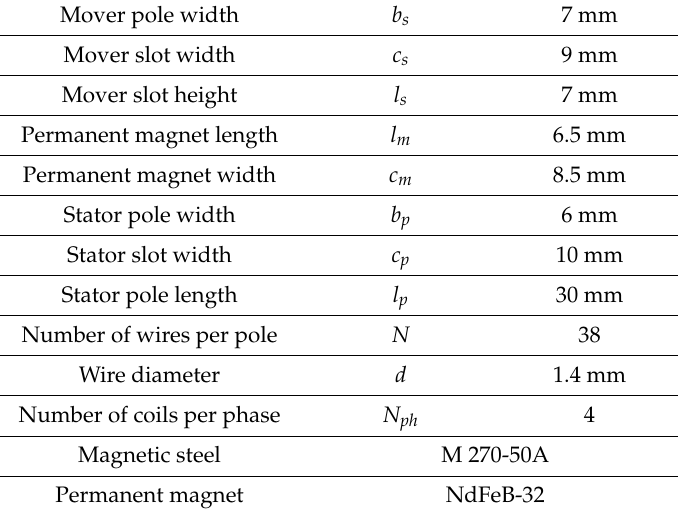
Figure A1. PM-LHRM main dimensions. Table A1. PM-LHRM main dimension values.